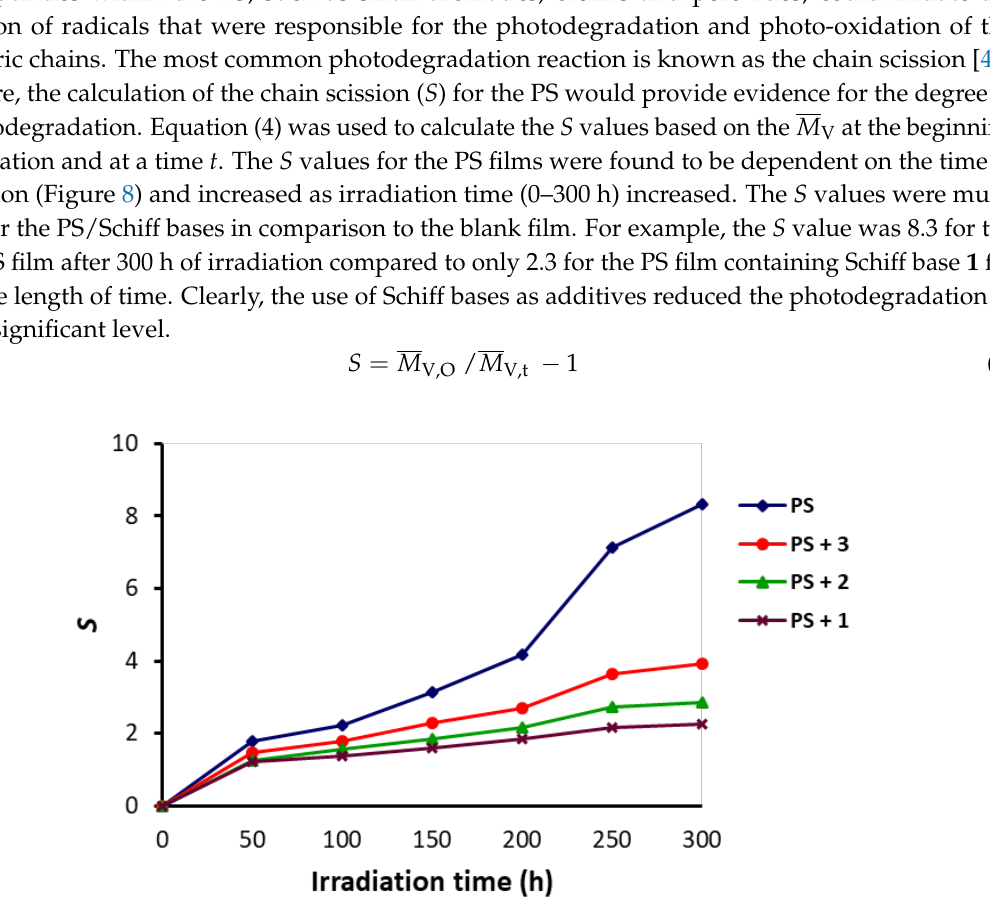
Figure 8. Changes in the S of PS upon irradiation.